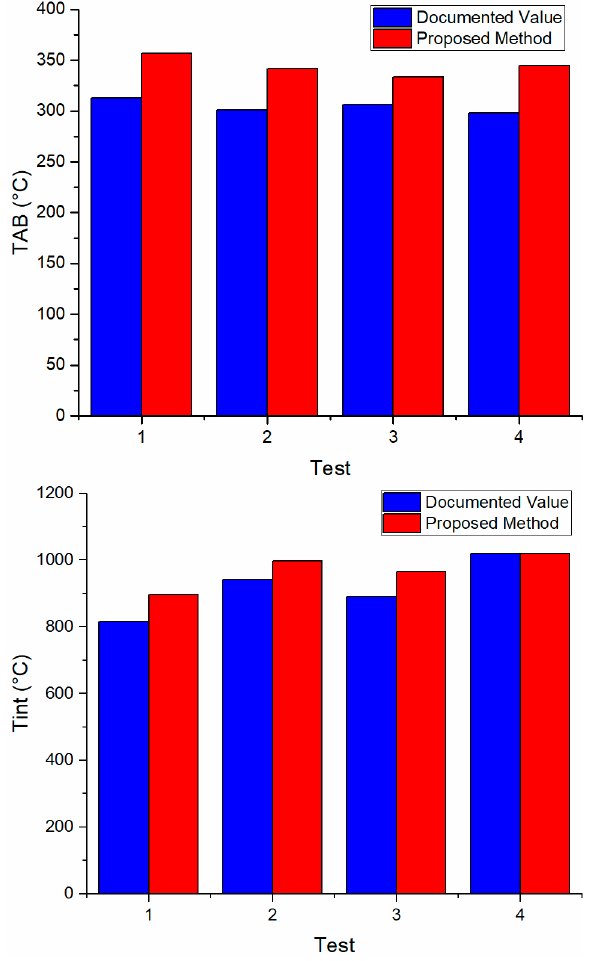
Figure 2. Temperature predictions in orthogonal machining of AISI 1045 steel. T AB ( top ) and T int ( bottom ) denote the average temperatures at primary shear zone (PSZ) and the average temperatures at secondary shear zone (SSZ) respectively.